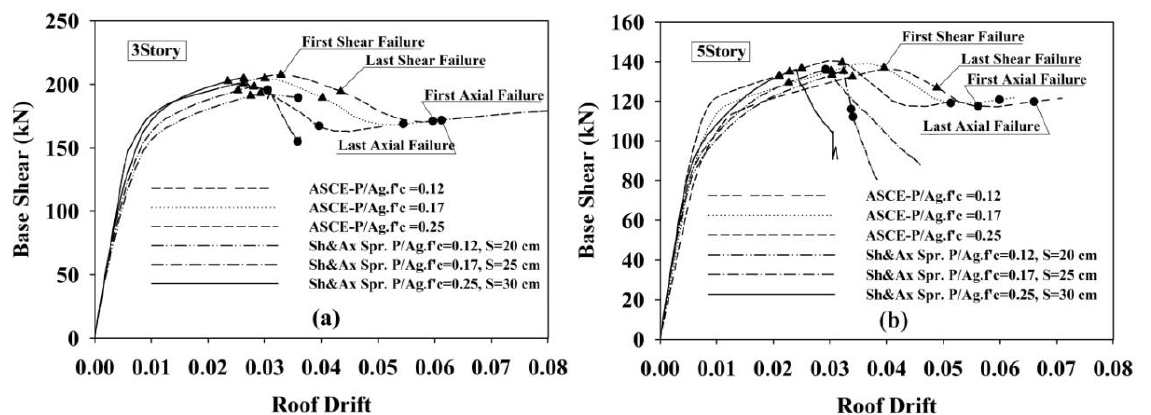
Fig. 8. Base shear - Roof drift plot due to non-linear pushover analysis in (a) 3-Story models and (b) 5- Story models.